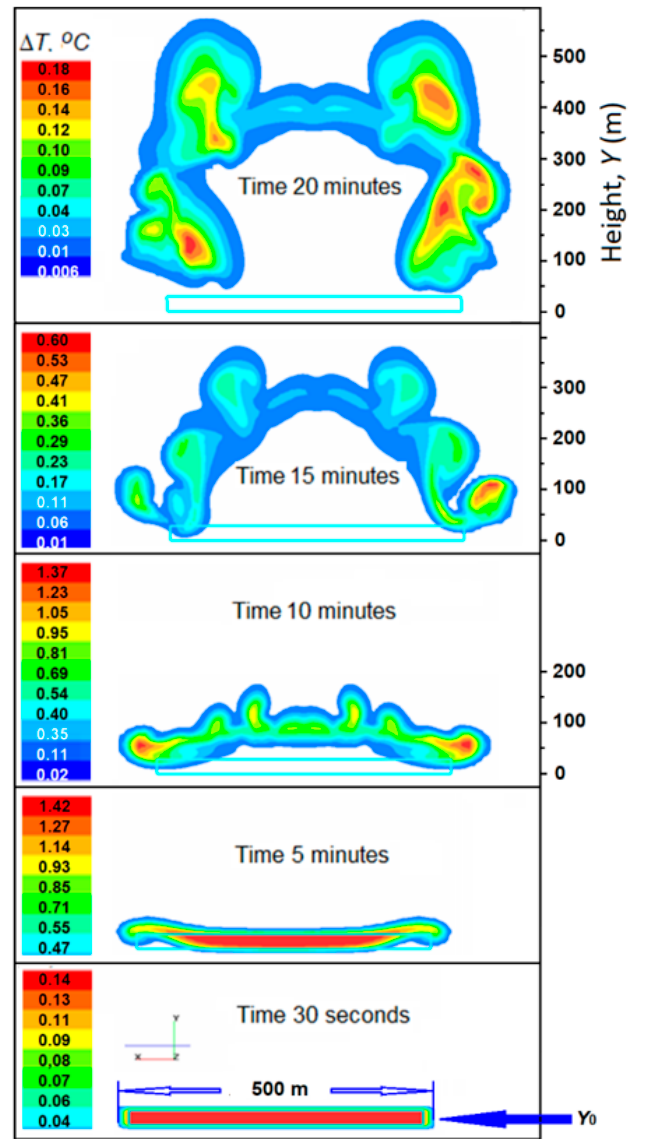
Figure 8. Air temperature rise ( Δ T °C) in the aerosol layer created by a pulsed aerosol source in a calm atmosphere at a TLR = 8.5 °C/km at the indicated times.